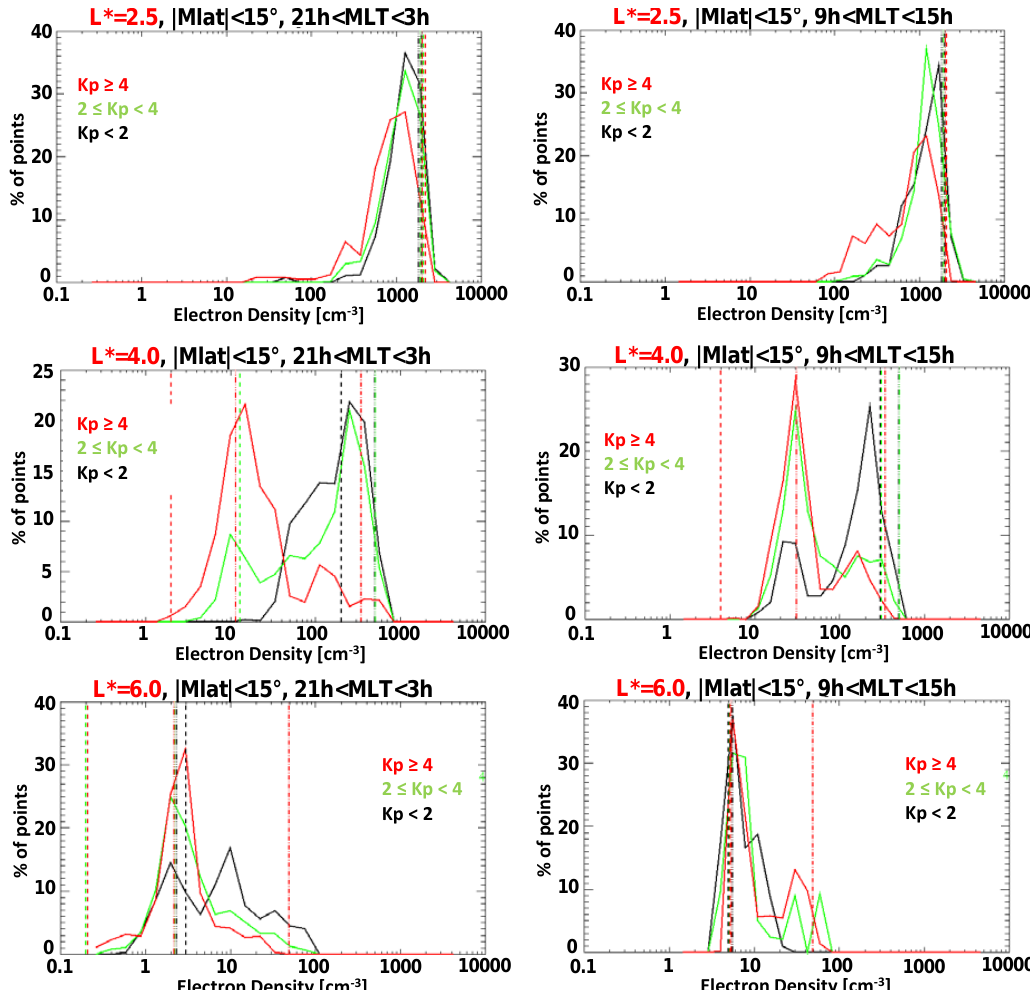
Figure 1. Electron plasma density (cm − 3 ) resulting from CRRES measurements versus percentage of points for three L ∗ values ( L ∗ = 2.5 on top, L ∗ = 4.0 in the middle and L ∗ = 6.0 at the bottom), for two MLT intervals (around midnight on the left and around noon on the right). On each plot, three magnetic activities are represented: quiet (in black), moderate (in green) and active (in red). Results from the GCPM , Sheeley and Carpenter models are also represented in dashed lines, dash-dot lines and dash-dot-dot-dot lines respectively.